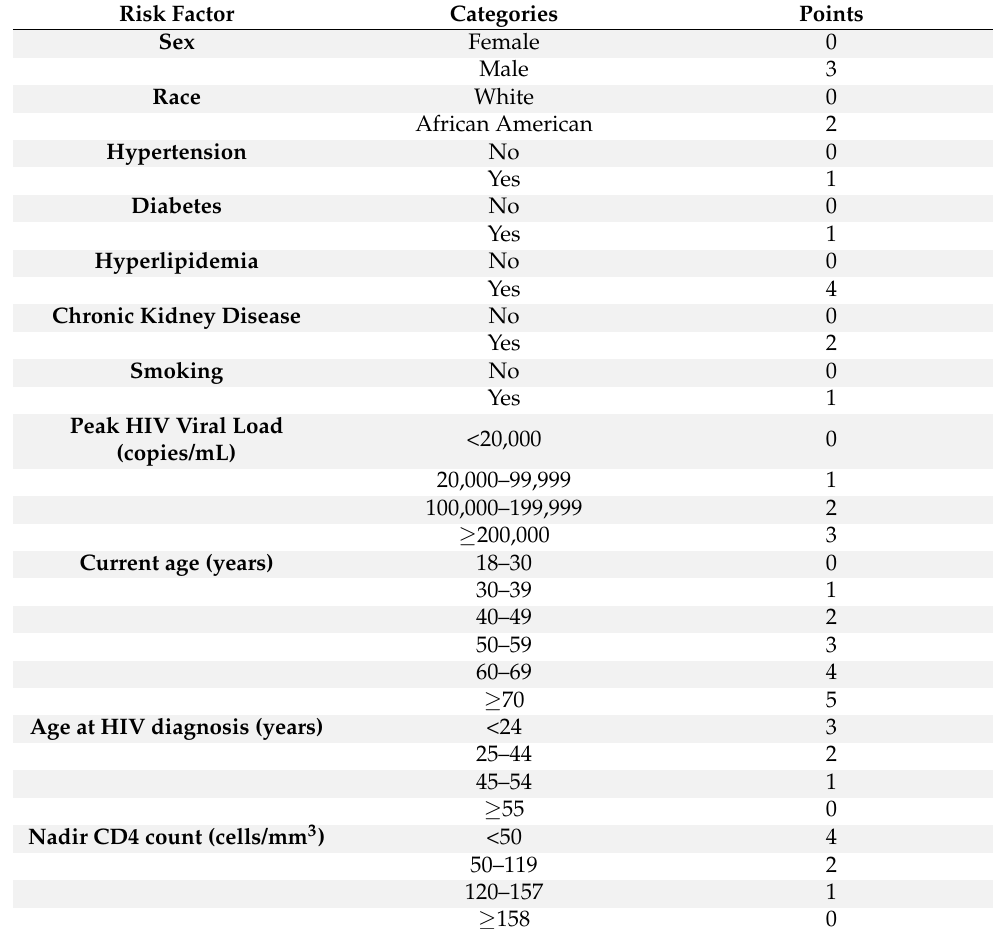
Table 3. Scoring system used for each risk factor.